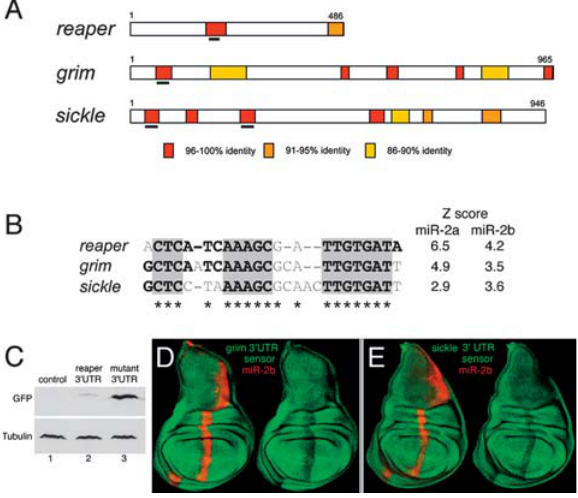
Figure 4. Experimental Validation of miR-2